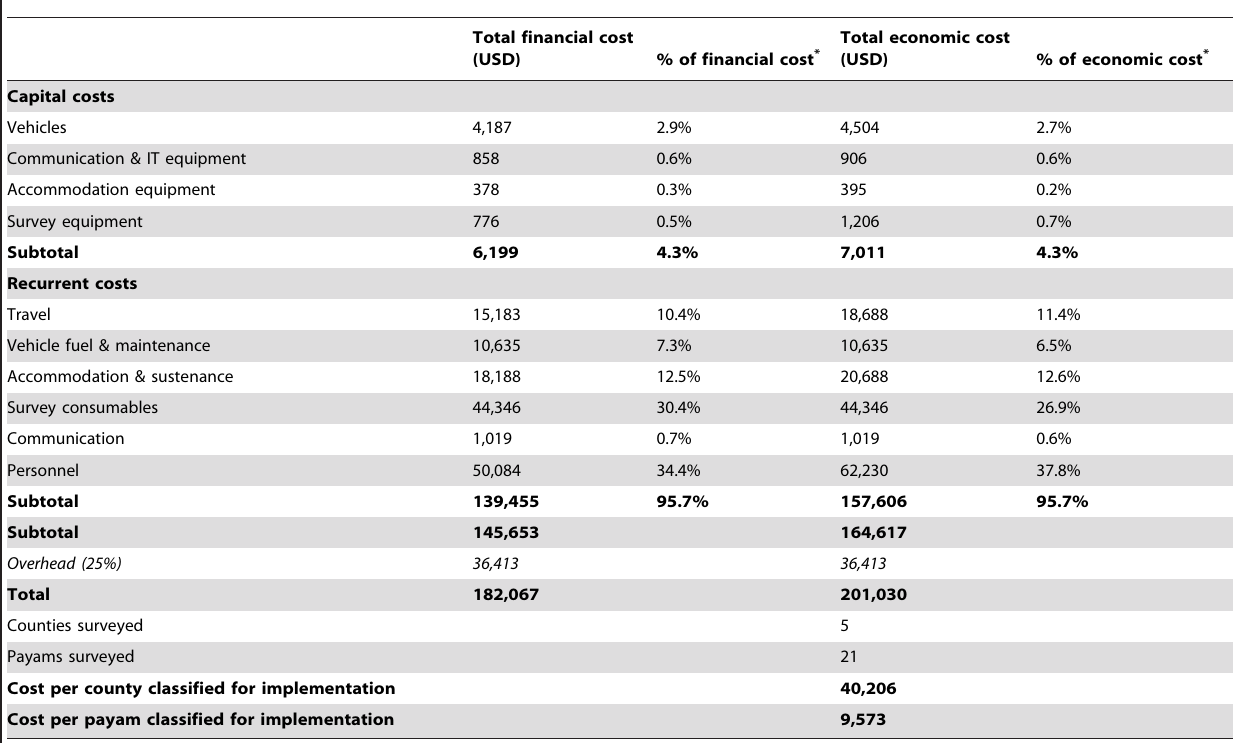
Table 2. Financial and economic costs, and cost profiles, for an integrated NTD survey in Northern Bahr-el-Ghazal